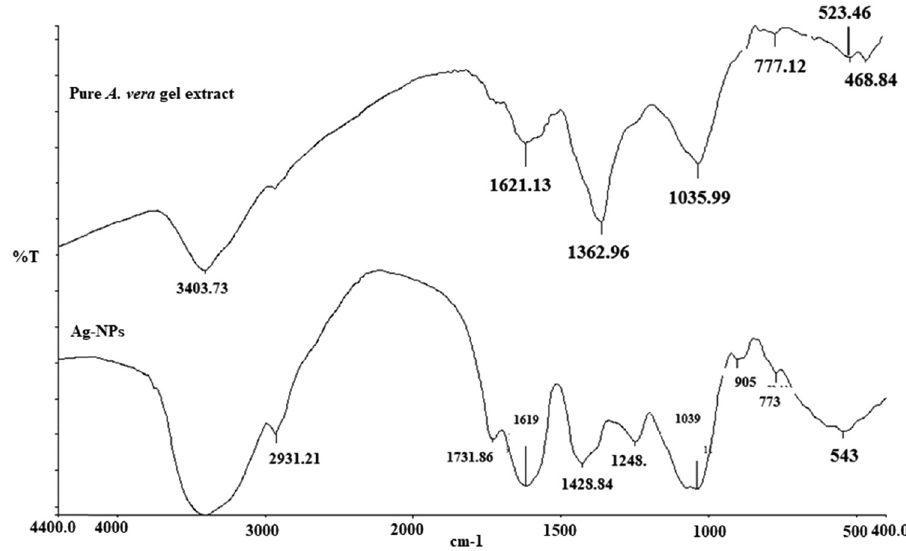
Figure 3: FTIR spectra of pure A. vera gel extract and the phytosynthesized Ag -